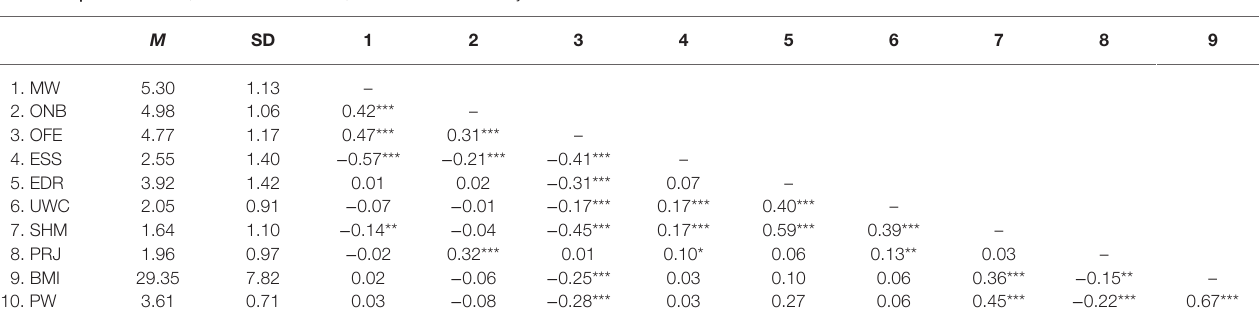
TABLE 2 | Scale means, standard deviations, and correlations Study 2.